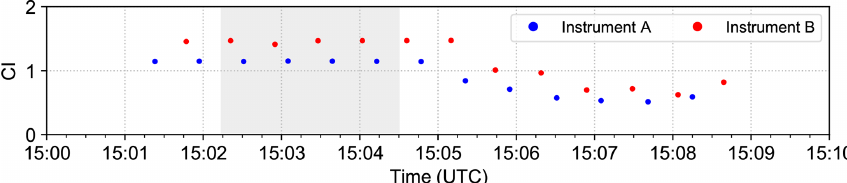
Figure B1. The temporal evolution of the colour index (CI; intensity ratio 320nm / 440nm) for the 90 ◦ measurements, which were taken simultaneously on the upwind side, is depicted. The shaded grey area depicts the range where both instruments measured the same NO 2 signal (compare to Fig.